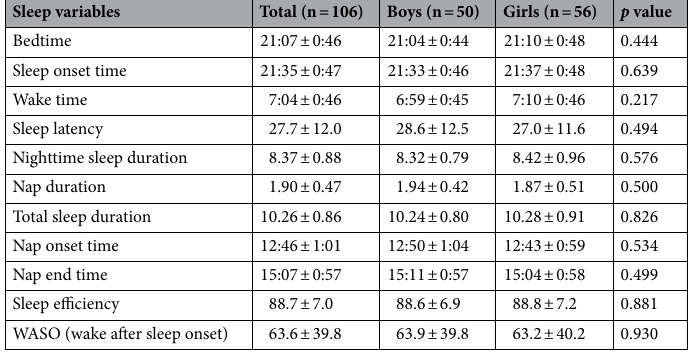
p = 0.001), suggesting that longer nap duration induces shorter nighttime sleep duration (Fig. 2a), as we previ- ously reported 17 . Also, unlike our previous report, no significant correlation was observed between nap end time and nighttime sleep duration (Fig. 2b). In addition, we found a significant correlation between nap onset time and nighttime sleep duration (r = 0.237, p = 0.015), which indicates that earlier nap onset time leads to shorter nighttime sleep duration (Fig. 2c). This correlation between nap onset time and nighttime sleep duration may be affected by the negative correlation between nap onset time and nap duration (r = − 0.362, p = 0.0001),